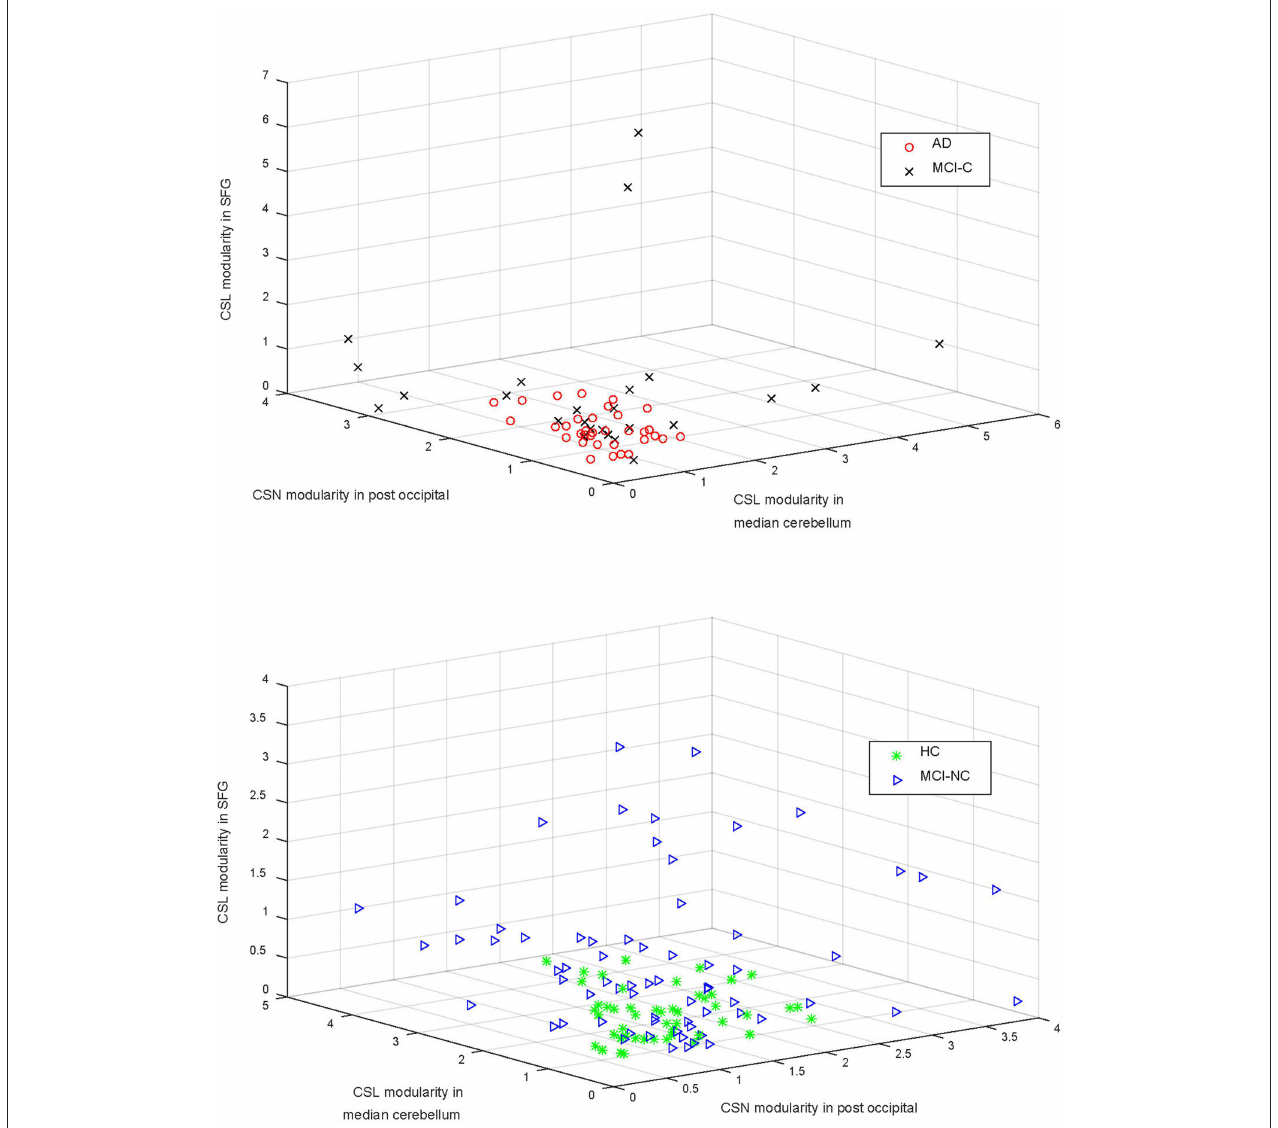
FIGURE 4 | The community structure Louvain (CSL) modularity and community structure Newman (CSN) modularity in three areas (i.e., superior frontal gyrus—SFG, median cerebellum, and post occipital cortex) are compared in the top and bottom panels for AD vs. MCI-C and HC vs. MCI-NC, respectively. Modularity of the brain network in these regions were significantly different in four groups ( P < 0.01; Table 4